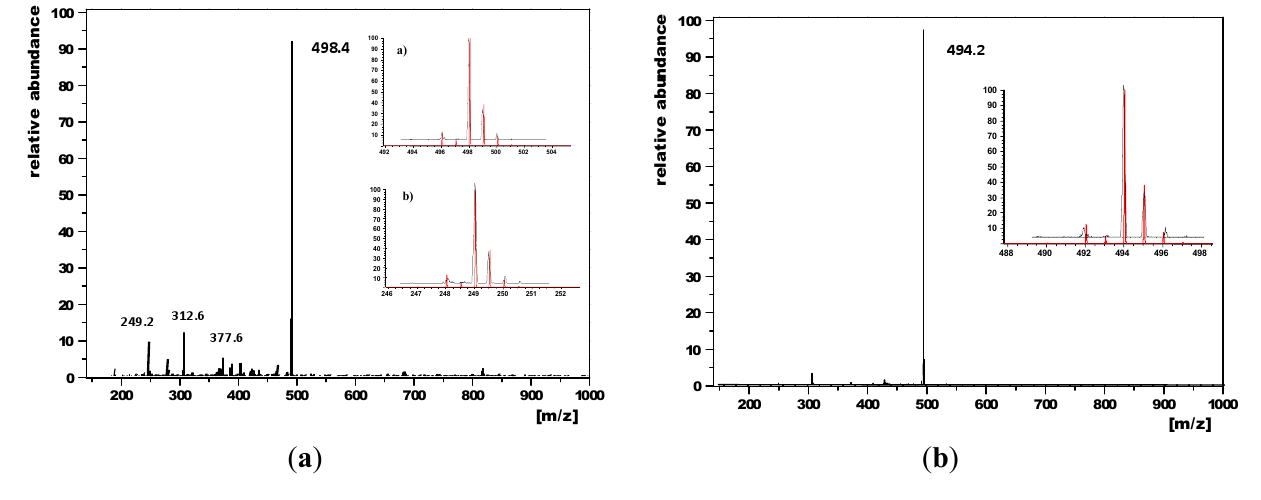
3 2+ ( b )) and 5 ( right ) along with their isotopic distributions (red: calculated, black: experimental